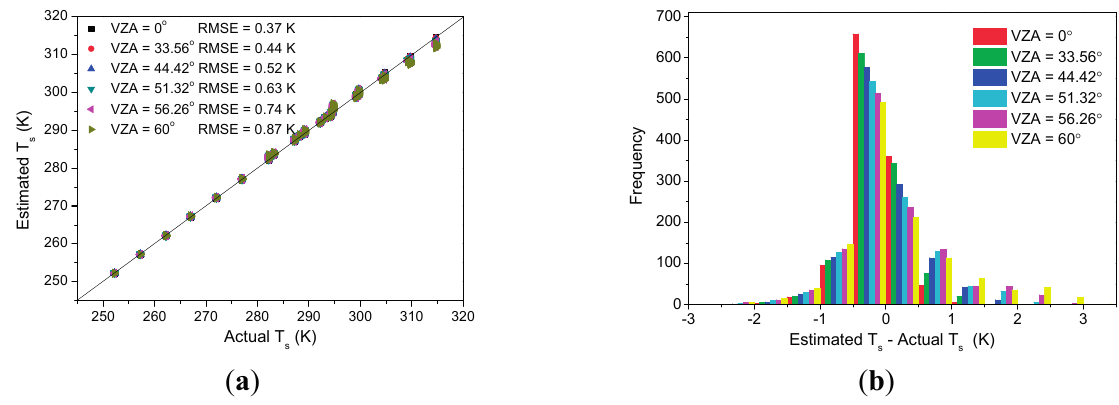
Figure 9. Comparisons ( a ) and difference histogram ( b ) of the actual LSTs ( i.e. , the MODTRAN 4 input LSTs) and those estimated using the proposed split-window algorithm for different types of surfaces, the six standard atmospheric profiles and the different